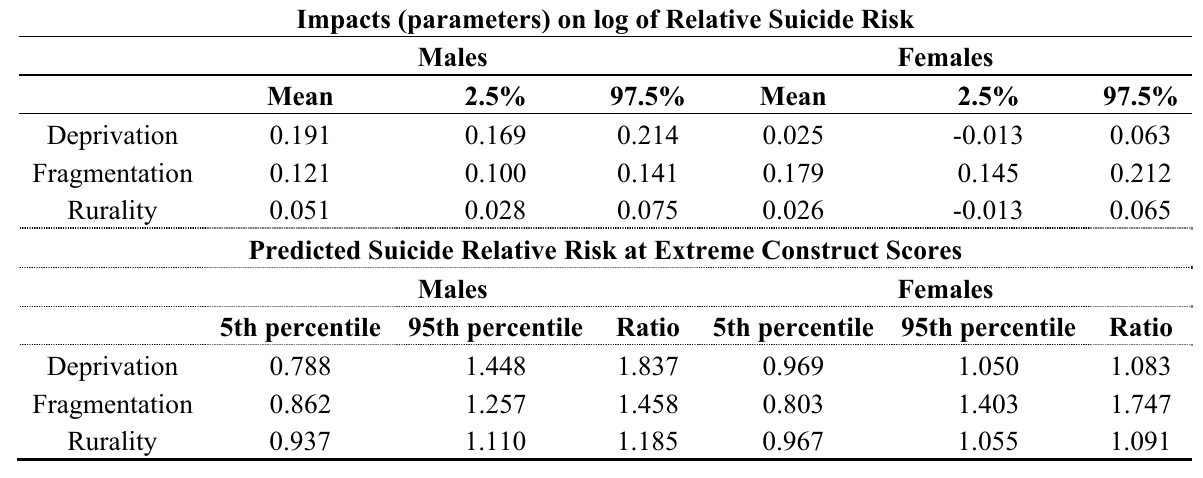
Table 4. Regression coefficients and predicted relative risks, suicide deaths by gender.